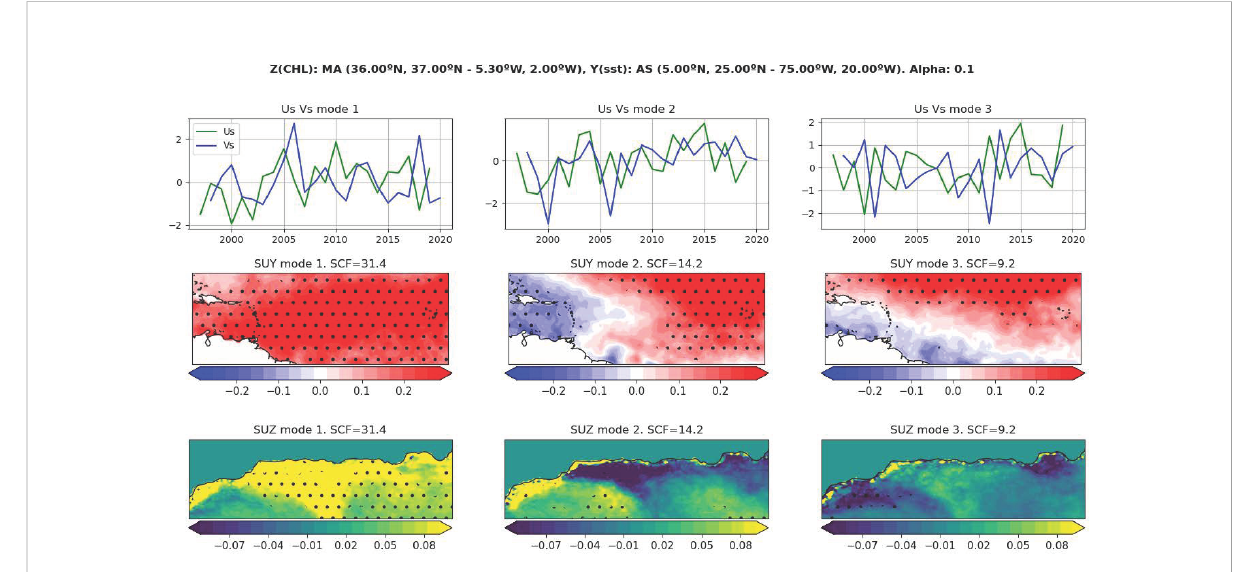
FIGURE 5 Three fi rst covariability modes between TNA SSTs in August – September (predictor fi eld) and Chl-a concentration in the following March – April in nAS (predictand fi eld). From left to right, the leading, second, and third modes. From top to bottom, the associated expansion coef fi cients (Us for the predictor fi eld and Vs for the predictand fi eld), spatial pattern of the predictor fi eld (anomalous SST; units in degrees per standard deviation in Us), and spatial pattern of the predict and fi eld (anomalous Chl-a; units in mg/m 3 per standard deviation in Us). Black marks in maps indicate statistically signi fi cant signals (p-values less than 0.05) based on a Student t-test. Central and bottom panels show, on top, the percentage of covariation explained by each pair of spatial